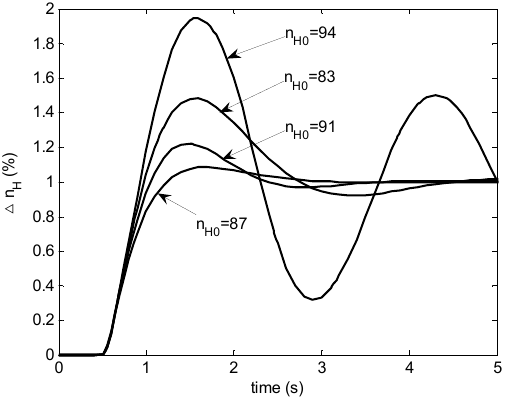
Figure 11. Step responses with H ∞ LPV controller.